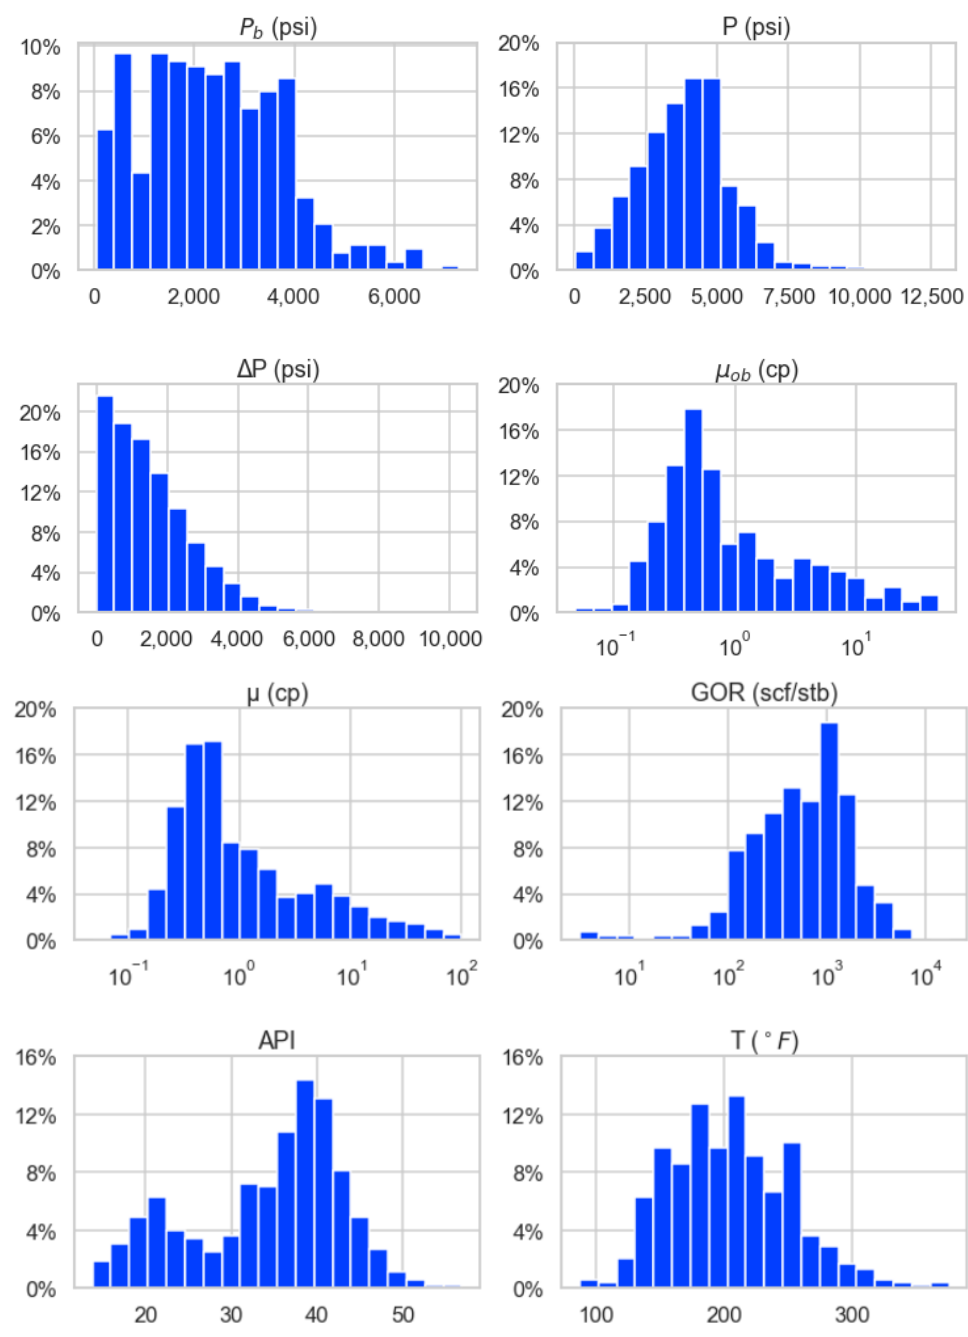
Figure 2. Fluid property values’